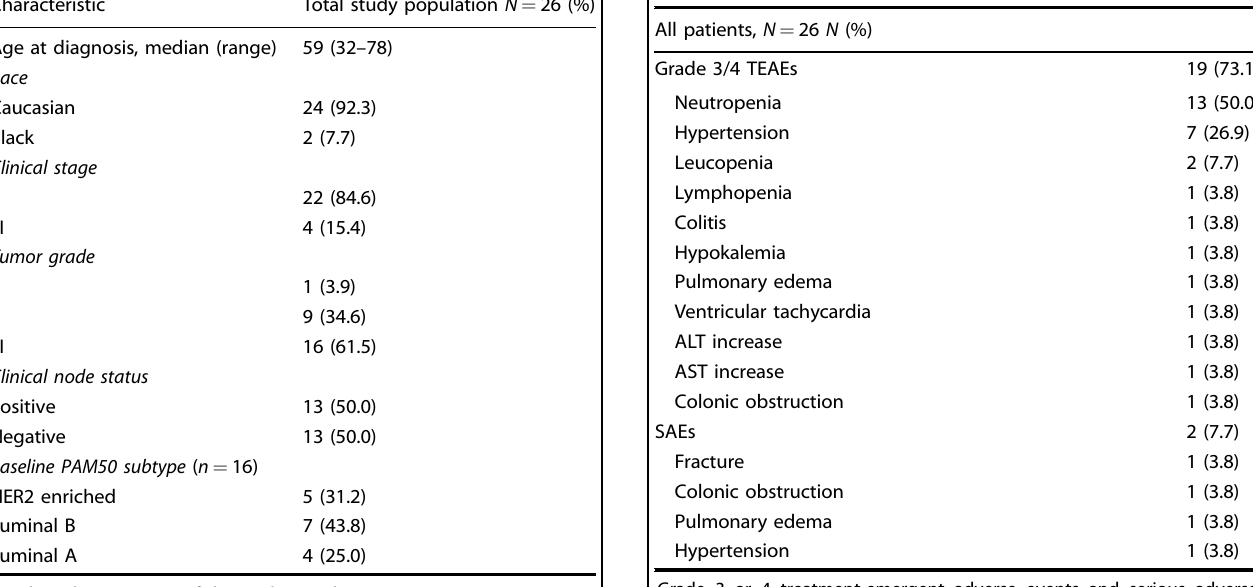
Table 1. Characteristics of the study population. Table 2. Treatment-emergent adverse events of ≥ grade 3 in study